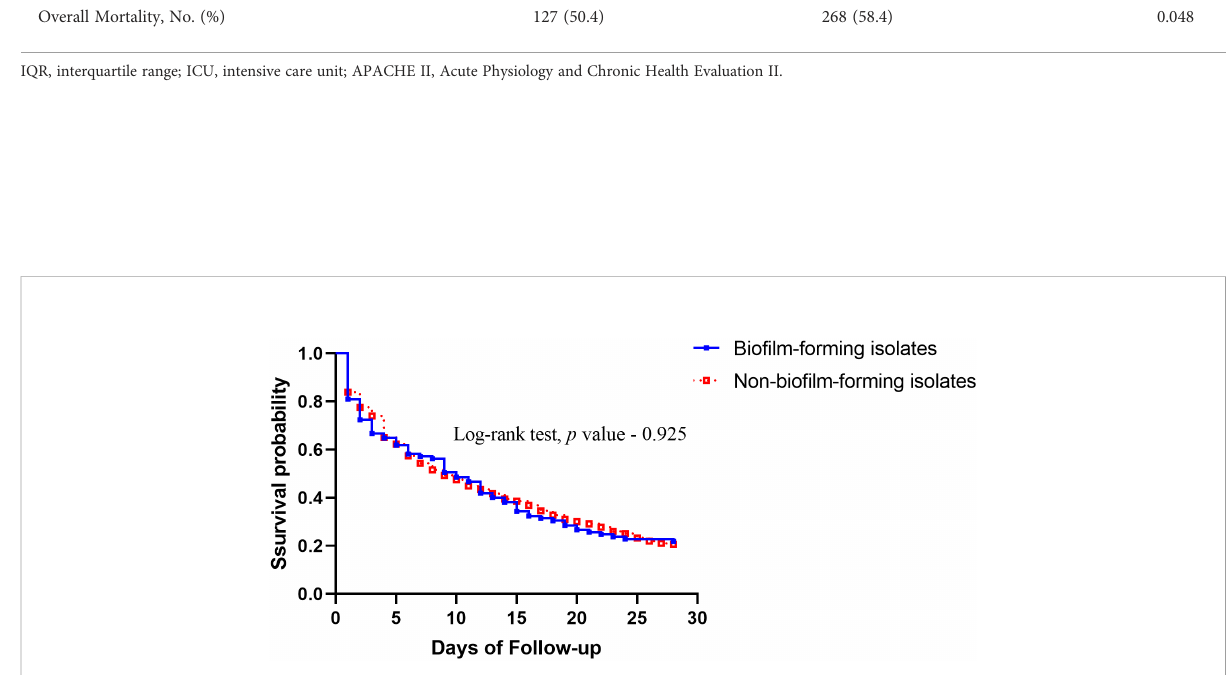
FIGURE 1 Comparison of Kaplan – Meier survival curves, at 28 days, between patients with Acinetobacter baumannii bacteremia caused by bio fi lm-forming isolates and non-bio fi lm-forming isolates.